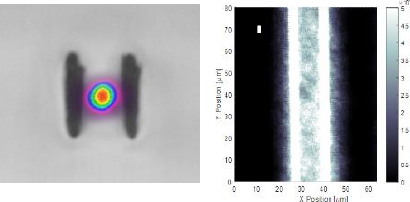
Fig. 3. Microfluidic channels realized by single pass Bessel beam (a) and multiple pass Gaussian (b) writing technique